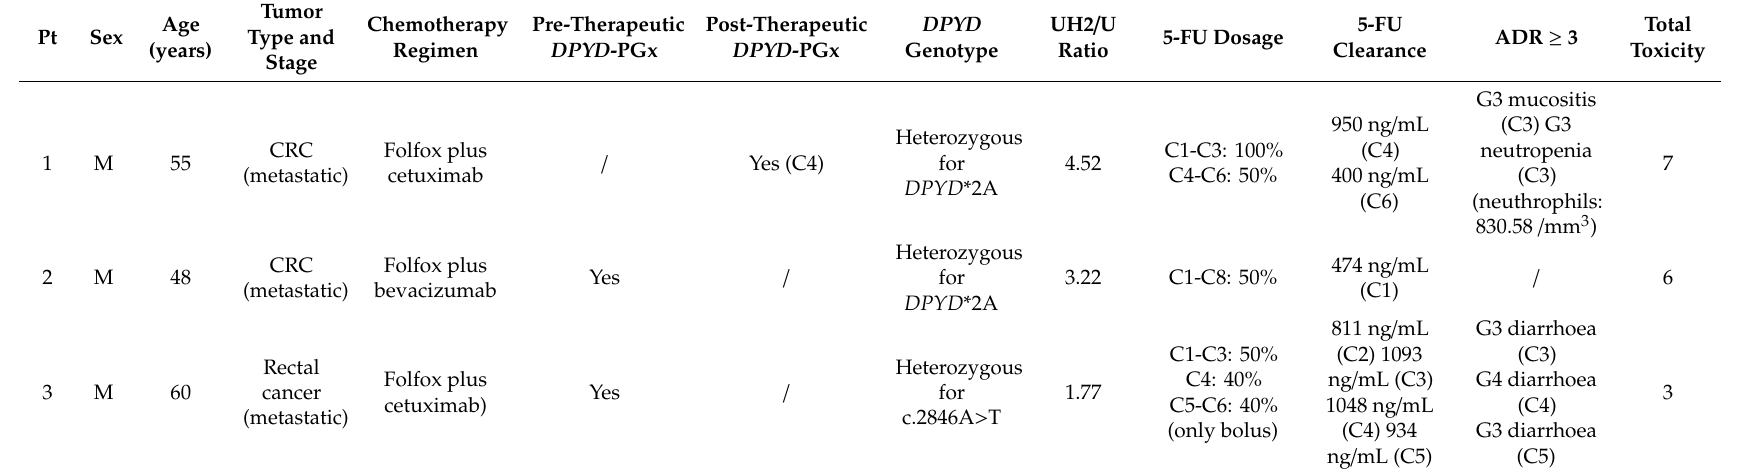
Table 1. Reports of the main characteristics of three patients with the occurrence of grade ≥ 3